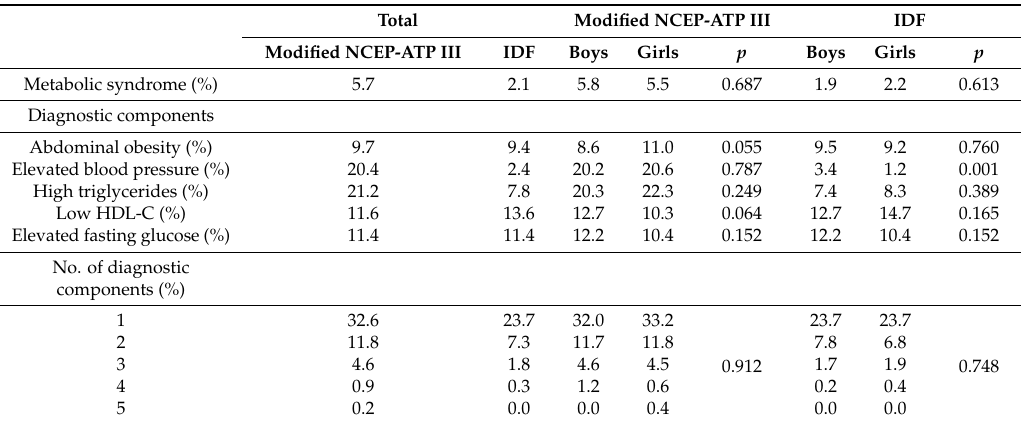
Table 3. Distribution of metabolic syndrome and diagnostic component